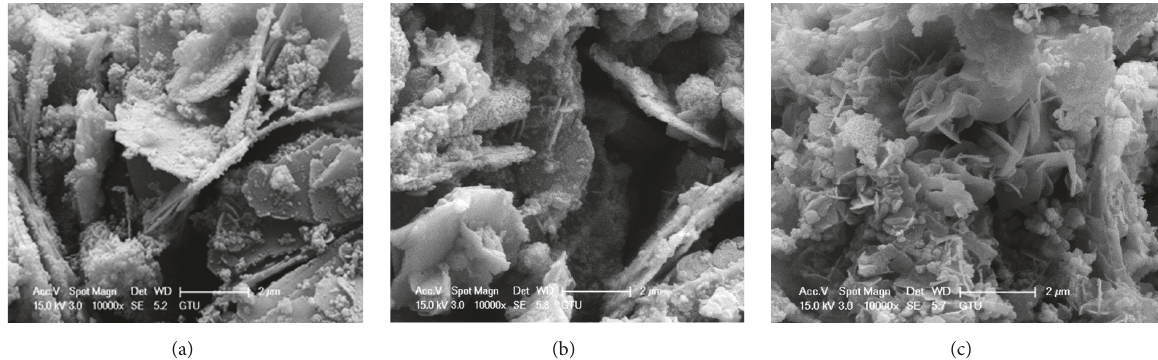
Figure 8: SEM micrographs of synthesized CIS powder at 240 ∘ C for (a) 10h, (b) 20 h, and (c) 40 h with polyetheramine.